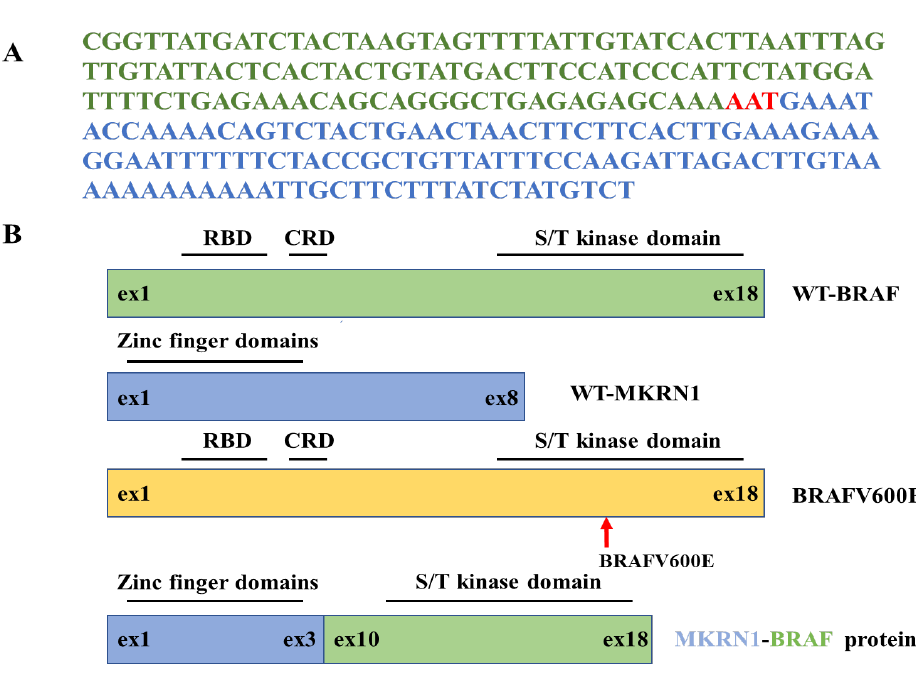
Figure 2. Detection of MKRN1-BRAF fusion by next-generation sequencing. ( A ) Representative part of NGS sequencing of the MKRN1 – BRAF fusion in THJ-16T cells. Green part, BRAF gene; blue part, MKRN1 gene; red part, the MKRN1-BRAF fusion. ( B ) Schematics of wild-type BRAF (green), wild-type MKRN1 (blue), BRAFV600E (yellow), and the fused MKRN1-BRAF proteins. The zinc finger domains of MKRN1 and the serine-threonine (S/T) kinase domain of BRAF remain intact in the fused protein. WT, wild-type; ex, exon; RBD, Ras-binding domain; CRD, cysteine-rich domain.